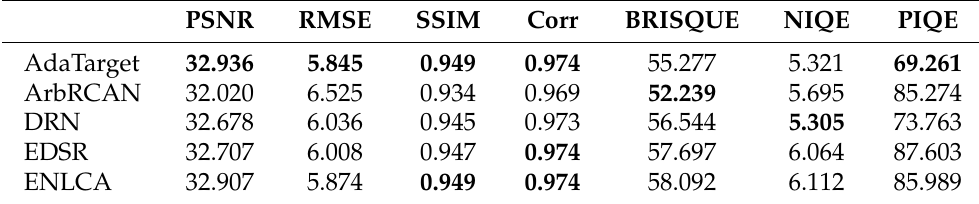
Table 2. Evaluation on FY4ASRgray with re-trained